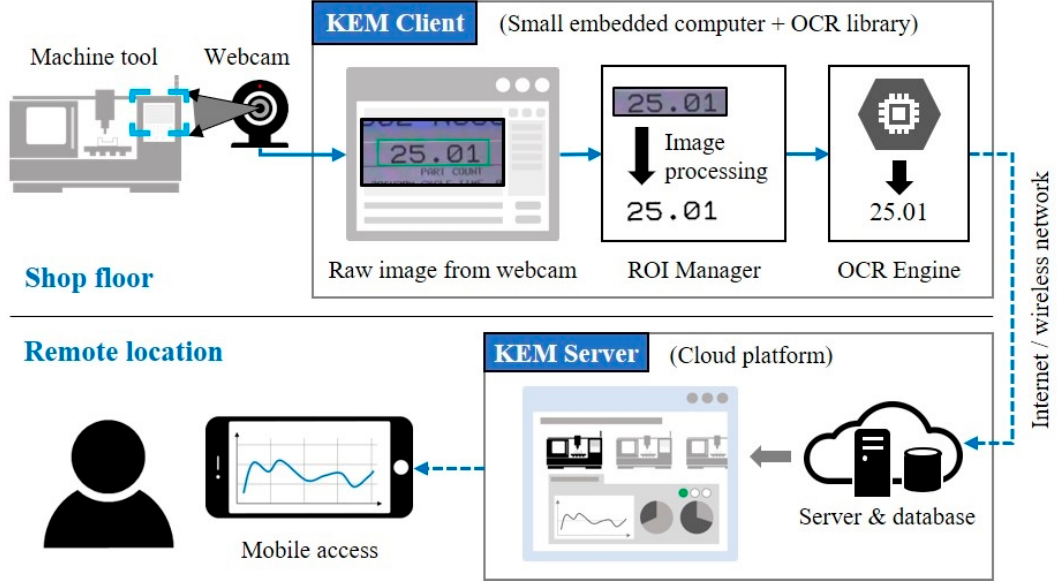
Figure 3. Comparison of the current status and proposed monitoring system.